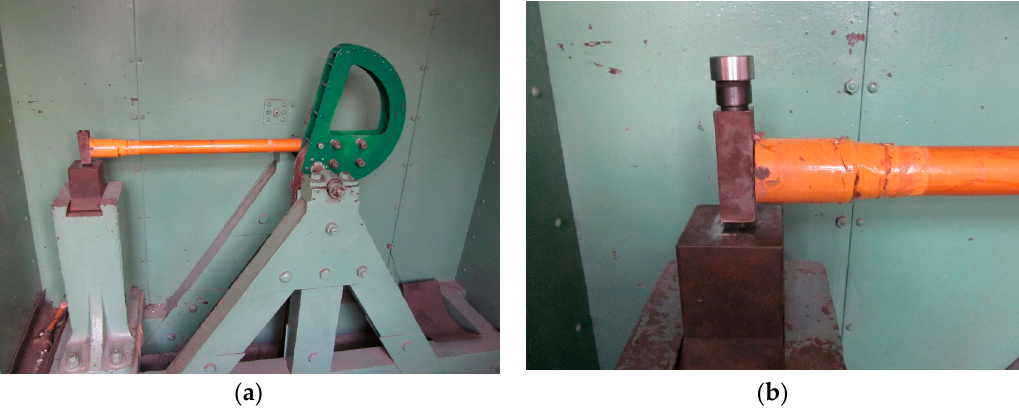
Figure 8. Machete hammer test machine. ( a ) The test machine. ( b ) The hammerhead and the test